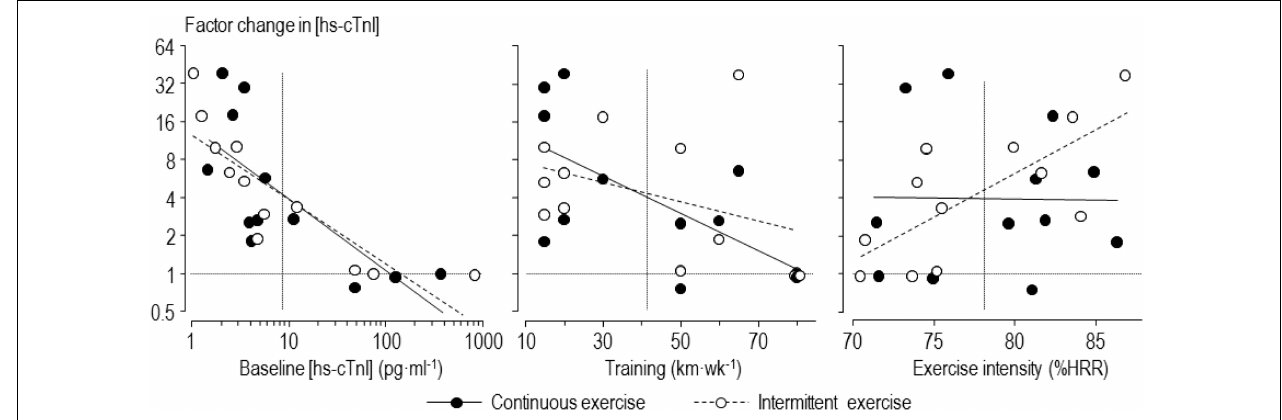
FIGURE 2 | Individual factor changes of high-sensitivity cardiac troponin-I (hs-cTnI) averaged over 0–24 h following intermittent and continuous exercise, with regression lines showing prediction by baseline concentration, training volume and exercise intensity. Horizontal dotted lines indicate no change in concentration; vertical dotted lines indicate mean values of the